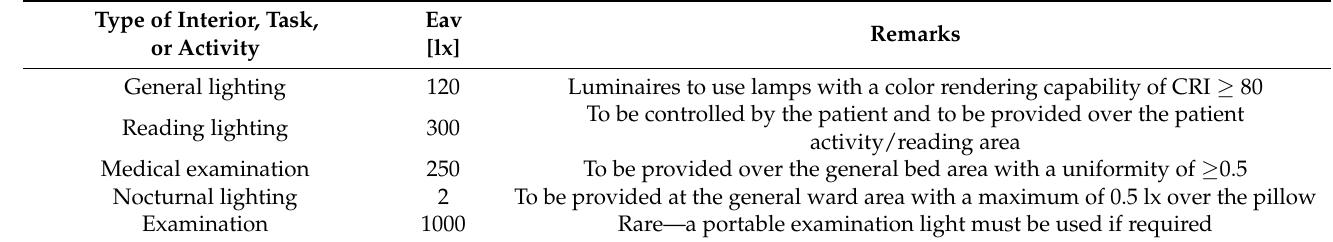
Table 1. Illuminance requirements for inpatient rooms.